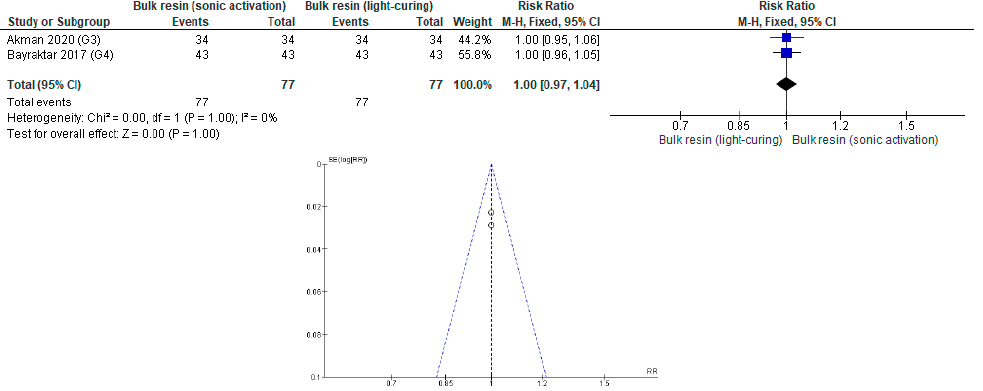
Figure A20. Absence of Post-Operative Sensitivity: Bulk Resin (with Sonic Activation) versus Bulk Resin (Two-Step Technique).